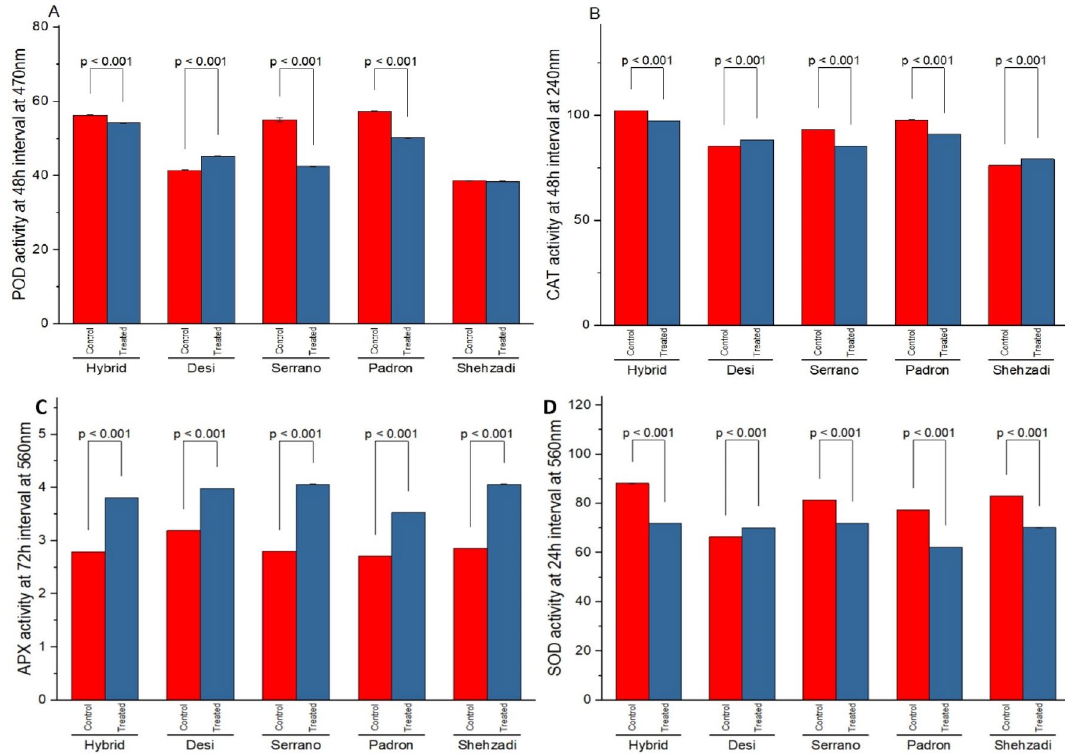
Figure 2. Antioxidant activity in Hybrid, Desi, Serrano, Padron, and Shehzadi chilli cultivars: ( A,B ) POD (U mg 1 FW) and CAT (U mg 1 FW) activity at 48 h, ( C ) APX activity at 72 h, and ( D ) SOD (U mg 1 FW) activity at 24 h with inoculation of the pathogen. Data is an average of 3 independent experiments following 3 replicates. Bar values indicates p-values at α <